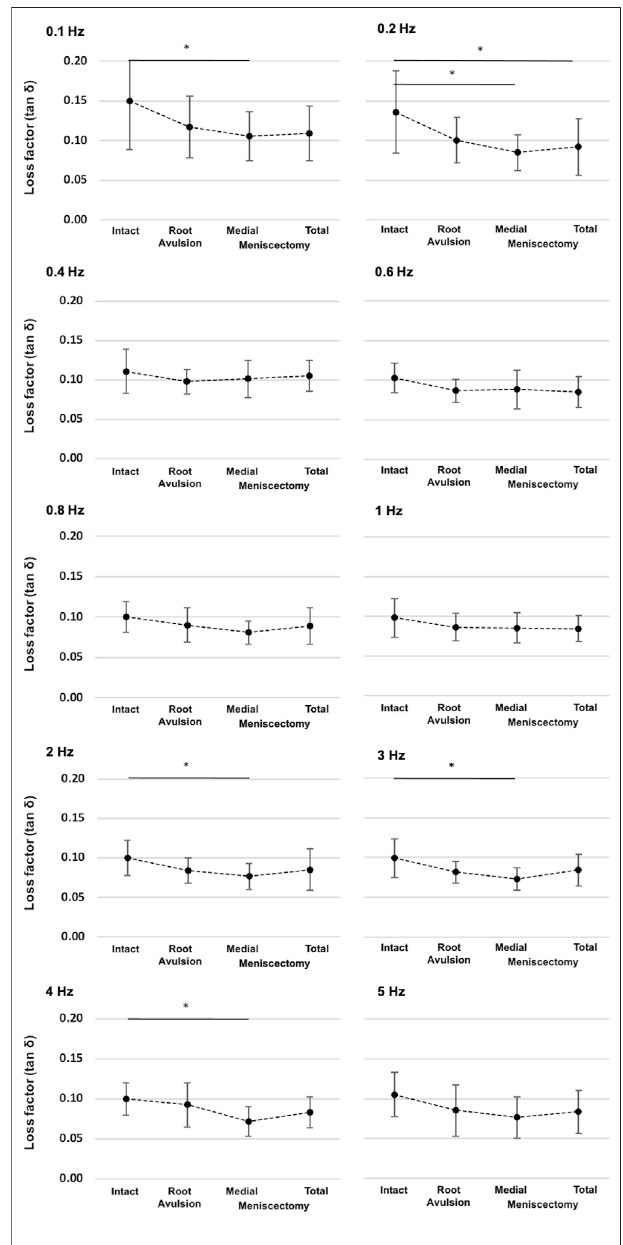
FIGURE 8 | Detailed representation of the loss factor (tan δ ) ± SD at the ten investigated frequencies (0.1 – 5 Hz) and under the four investigated meniscus states: intact, root avulsion at the posterior horn of the medial meniscus, medial meniscectomy, and total lateral and medial meniscectomy. The dotted line indicates the progression of the consecutively investigated meniscus states. *One-way ANOVA with post-hoc Duncan test: * p < 0.05; n =